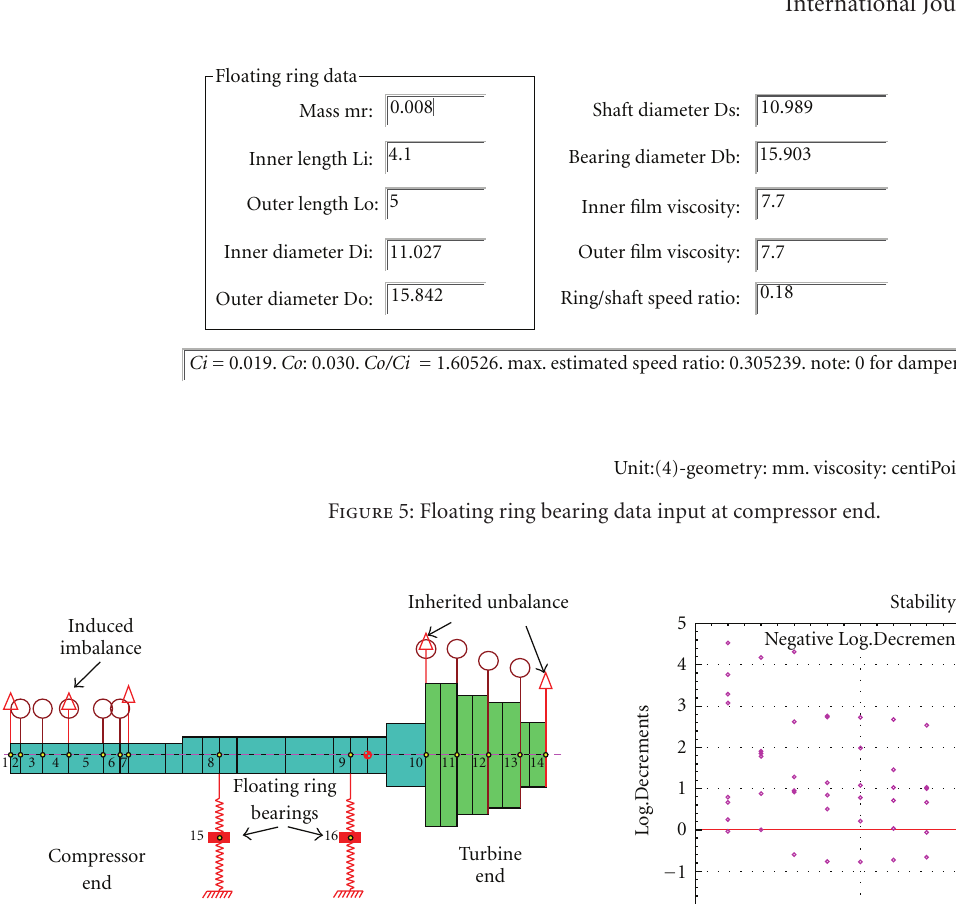
Figure 6: Turbocharger finite-element model with induced imbal- ance at the compressor wheel.